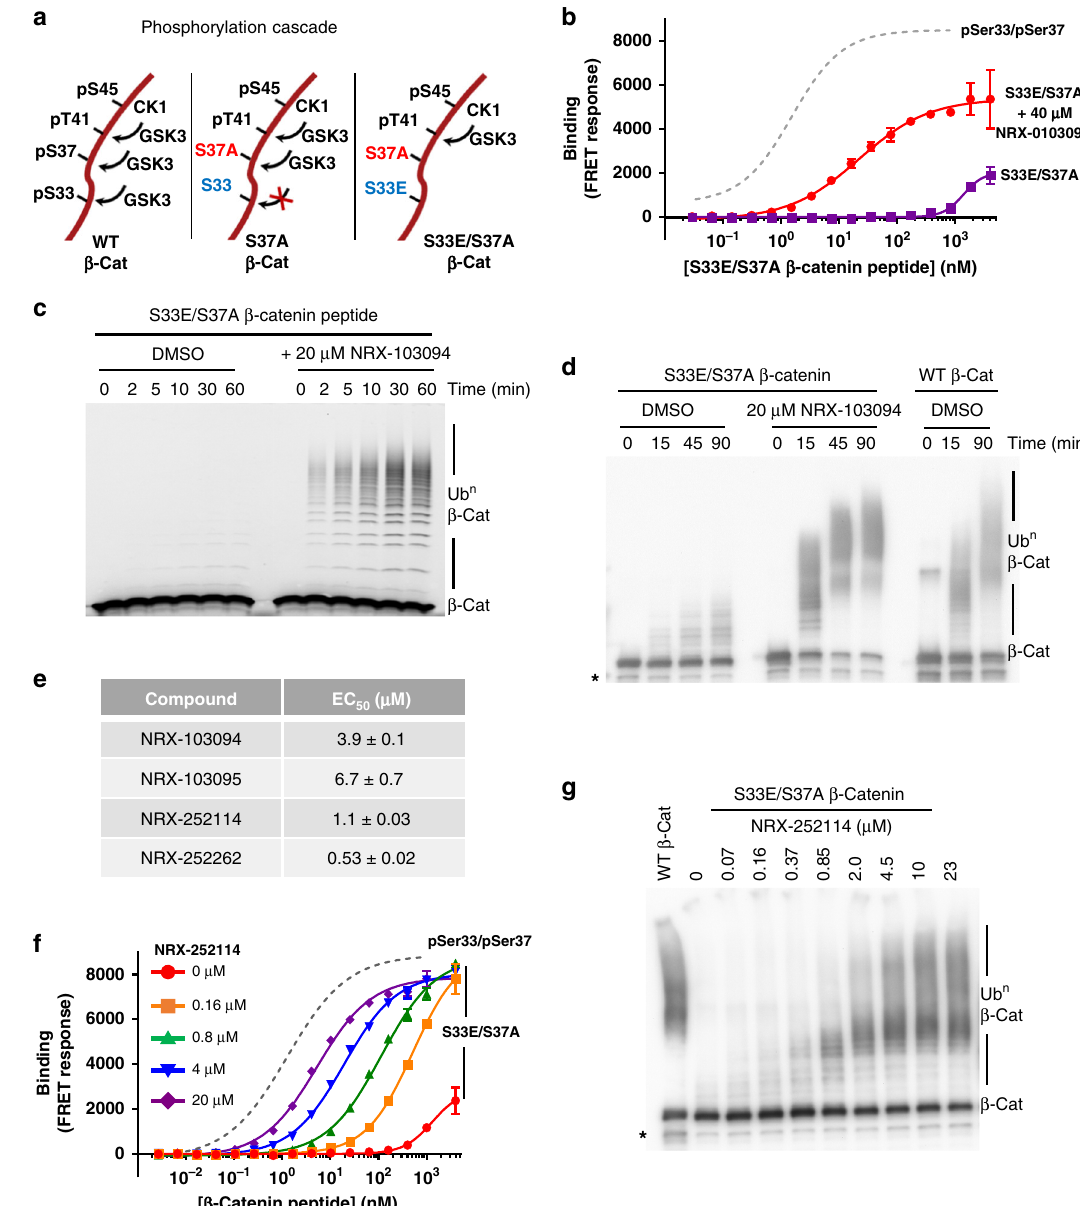
Fig. 5 Enhancers potentiate binding and ubiquitylation of S33E/S37A phosphomimetic β -catenin. a Schematic of the proposed phosphorylation cascade for WT and S37A, S33E/S37A mutant β -catenin. b Binding curve of S33E/S37A β -catenin peptide for β -TrCP measured in the TR-FRET assay in absence or presence of 40 μ M NRX-103094. For reference, the binding curve for pSer33/pSer37 β -catenin peptide in the same TR-FRET assay is represented in dotted gray line. c 4 μ M of fl uorescently-labeled S33E/S37A β -catenin peptide (residues 17 – 60) was ubiquitylated in the presence of 125 nM Ube1, ATP, 1.75 μ M Cdc34, 100 nM SCF β -TrCP , and 20 μ M NRX-103094. Reactions were resolved by SDS-PAGE and imaged for fl uorescence. d 400nM puri fi ed full-length β - catenin protein (as indicated) was ubiquitylated in the presence of 125 nM Ube1, ATP, 1.75 μ M Cdc34, 400nM SCF β -TrCP , and 20 μ M NRX-103094. Reactions were resolved by SDS-PAGE and analyzed by immuno-blotting with a β -catenin C-terminal antibody (* refers to degradation products). e Enhancer potencies for S33E/S37A β -catenin peptide binding to β -TrCP. Due to low intrinsic binding af fi nity, the pSer33/pSer37 β -catenin binding assays were carried out at 1% binding saturation. f Binding curve of S33E/S37A β -catenin peptide for β -TrCP measured in the TR-FRET assay in presence of varying NRX-252114 concentration. For reference, the binding curve for pSer33/pSer37 β -catenin peptide in the same TR-FRET assay is represented in dotted gray line. g Ubiquitylation of full-length S33E/S37A β -catenin protein in the presence of varying concentration of NRX-252114 (as described above; * refers to degradation products) NATURE COMMUNICATIONS| (2019) 10:1402